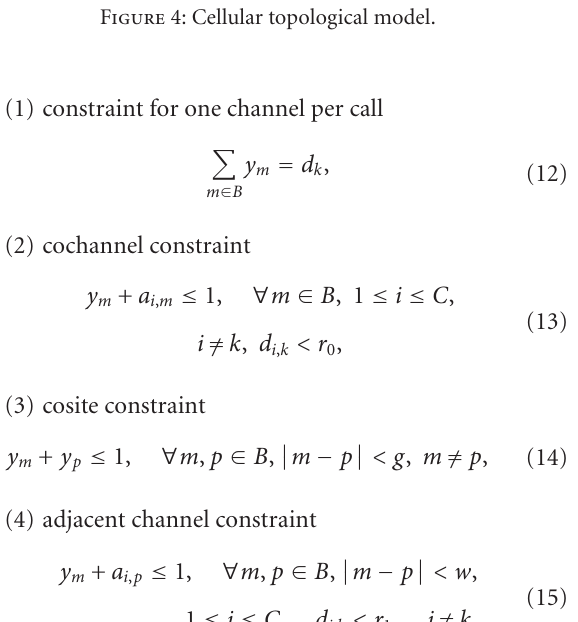
Figure 4: Cellular topological